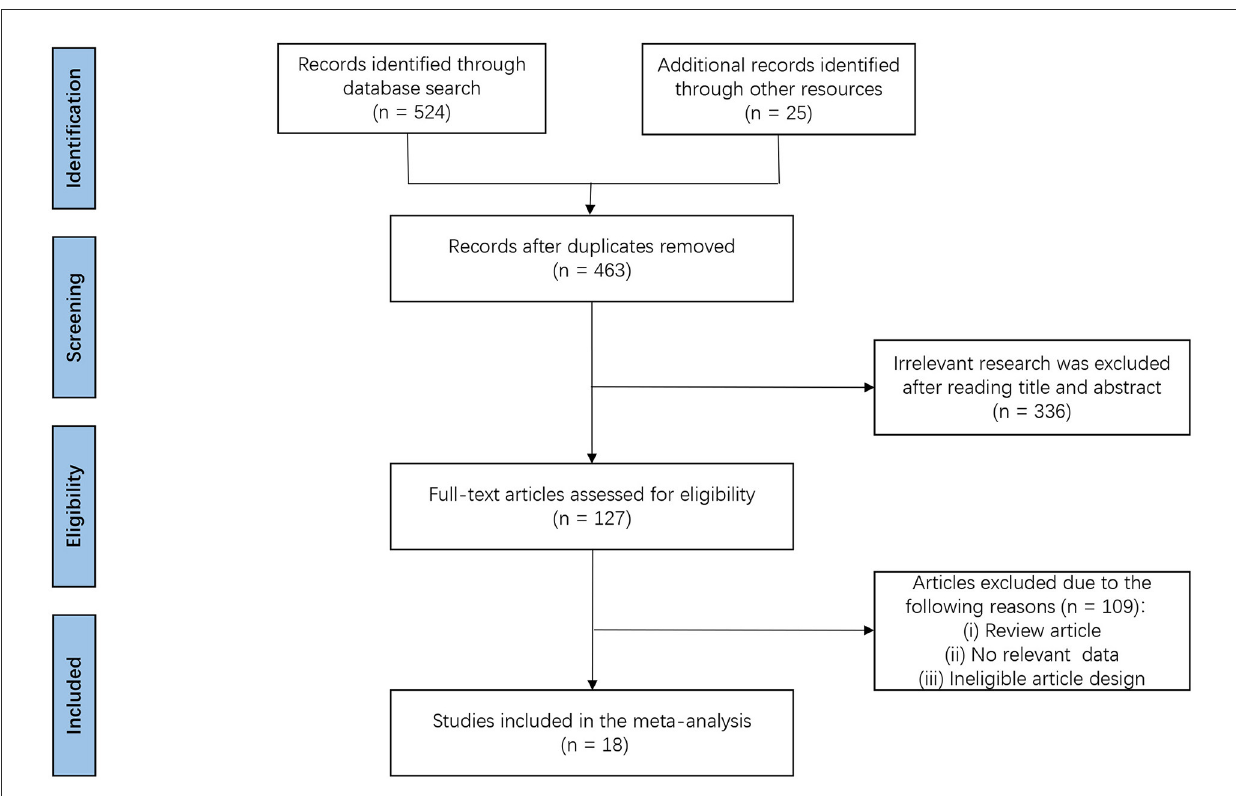
FIGURE1 Flow diagram of literature search and study